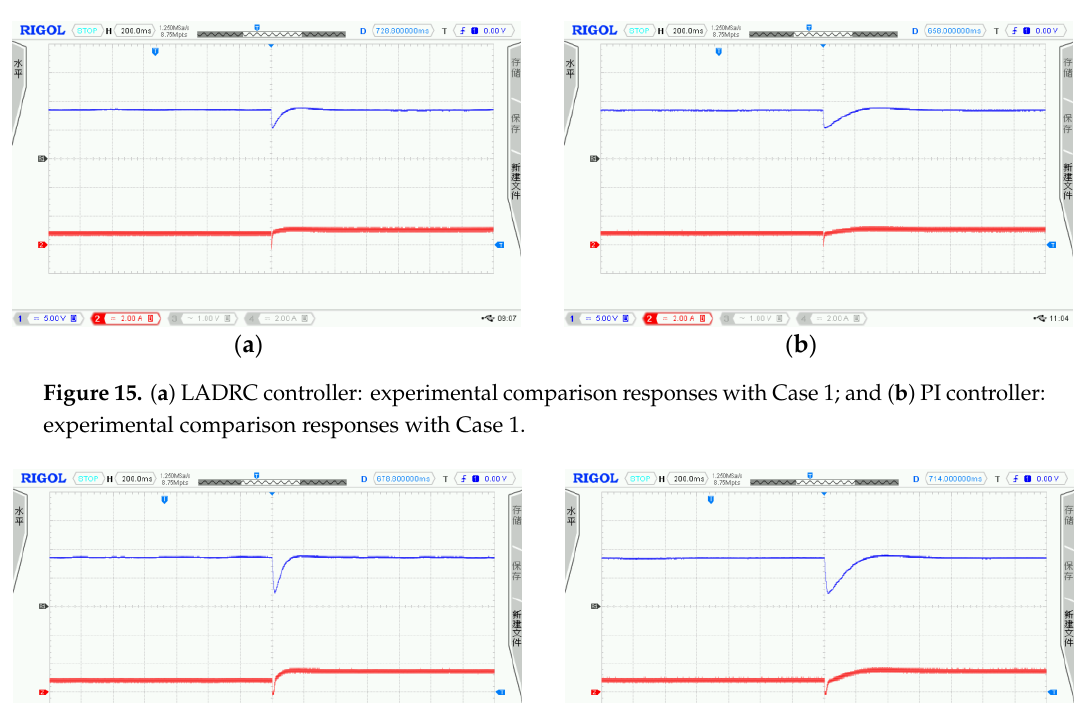
Figure 14. DC/DC boost converter experimental platform.